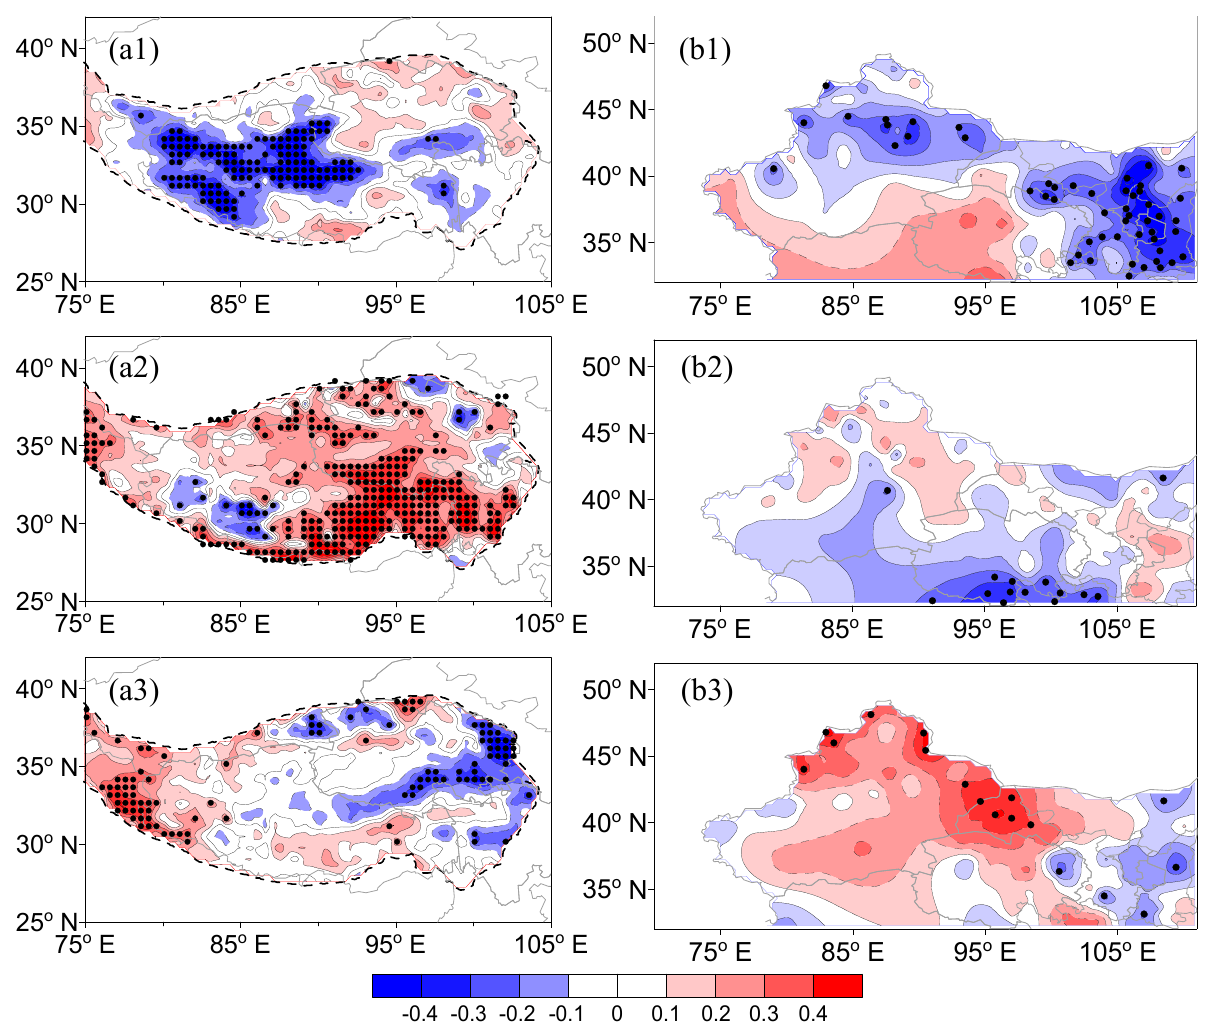
Figure 4. The spatial distributions of the correlation coefficients of the first three SVD modes of the spring snowmelt over the TP and spring precipitation in Northwest China (from top to bottom: SVD1, SVD2 and SVD3): ( a ) the TP spring snowmelt field; ( b ) the spring precipitation field in NWC. The black spot areas passed the 95% significance test.